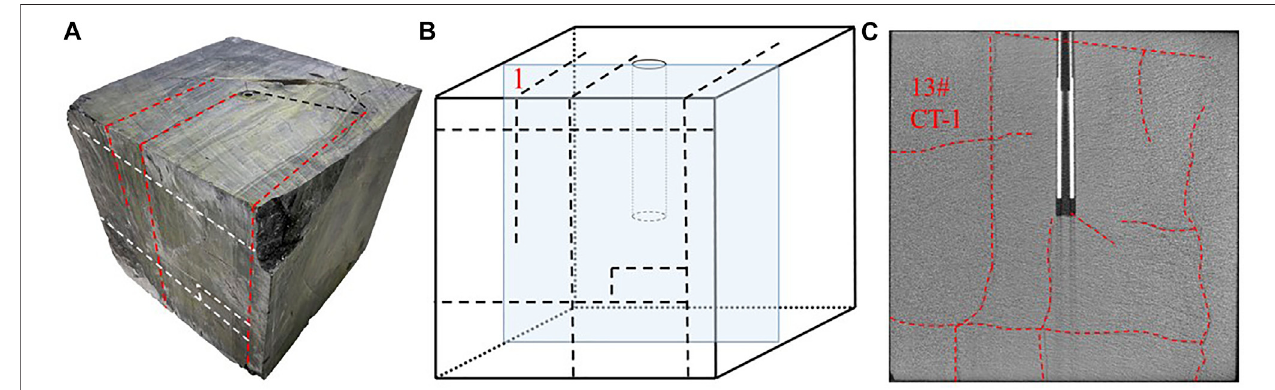
FIGURE 8 | Fracture morphology created by supercritical CO 2 on a specimen with nature fractures: (A) Fracture morphology of specimen 13#; (B) Scanning position of specimen 13#; (C) Scanning image of specimen 13#.